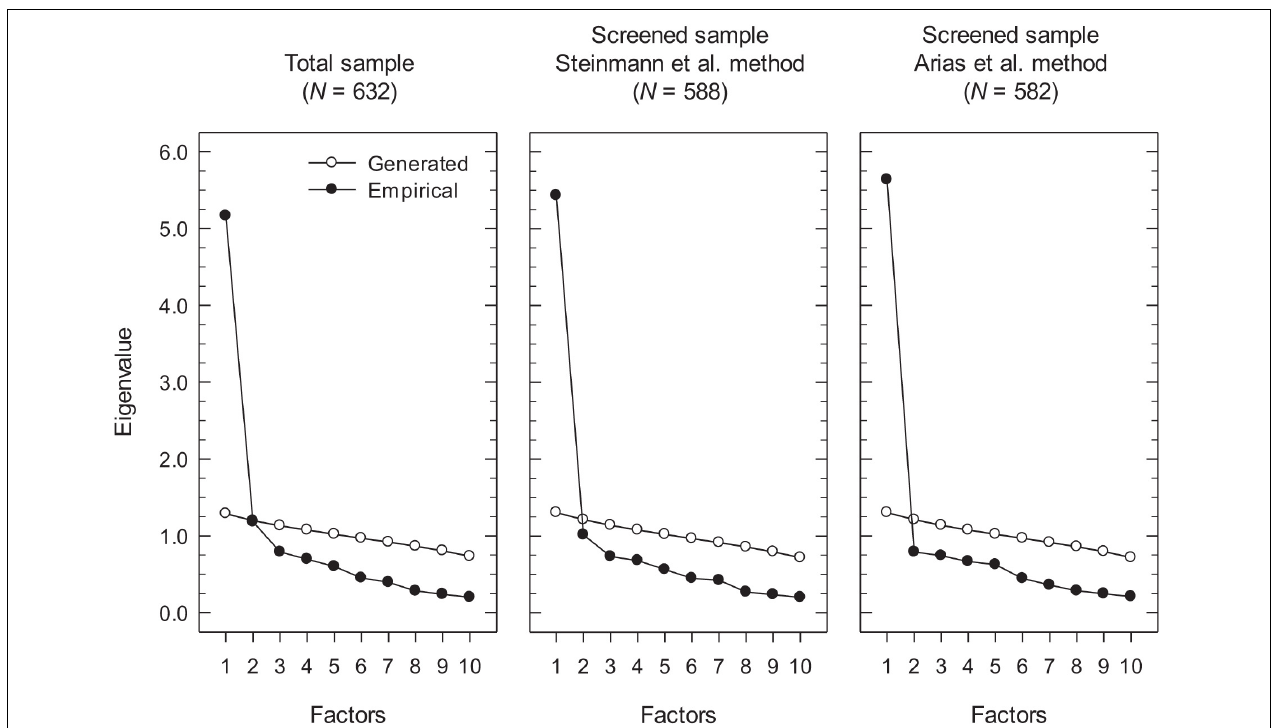
FIGURE 2 | Dimensionality assessment of the RSES scores with parallel